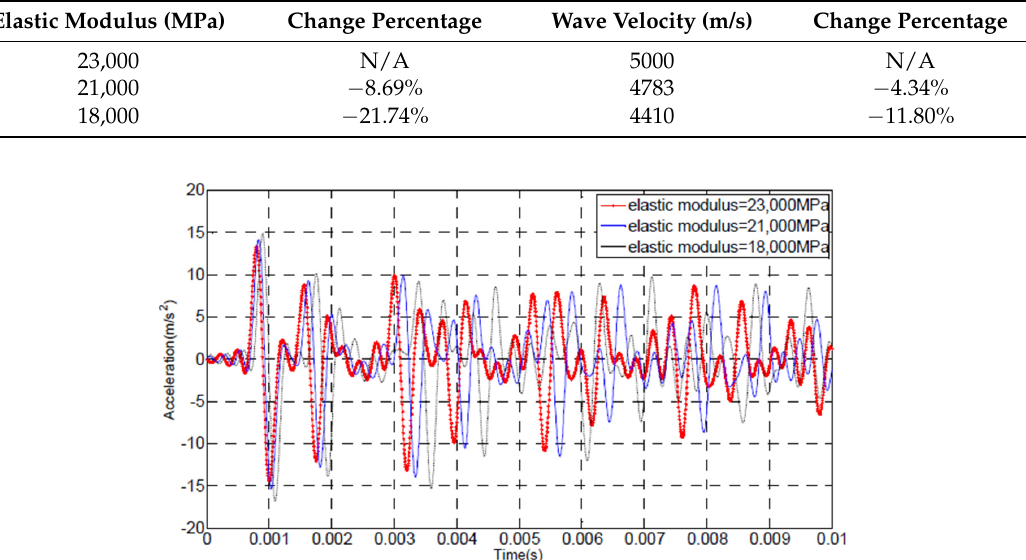
Figure 12. Effect of elastic modulus on wave behaviour in the isotropic material model.